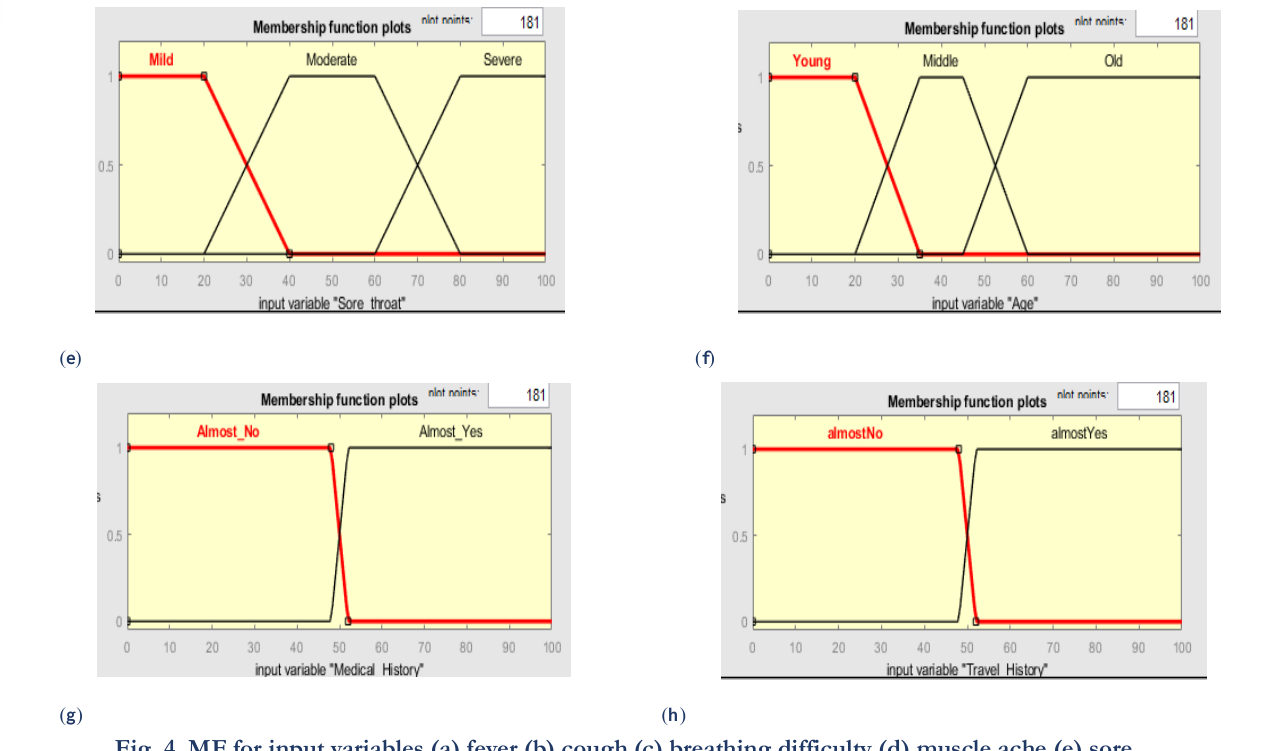
Fig. 4. MF for input variables (a) fever (b) cough (c) breathing difficulty (d) muscle ache (e) sore throat (f) travel history (g) age (h) medical